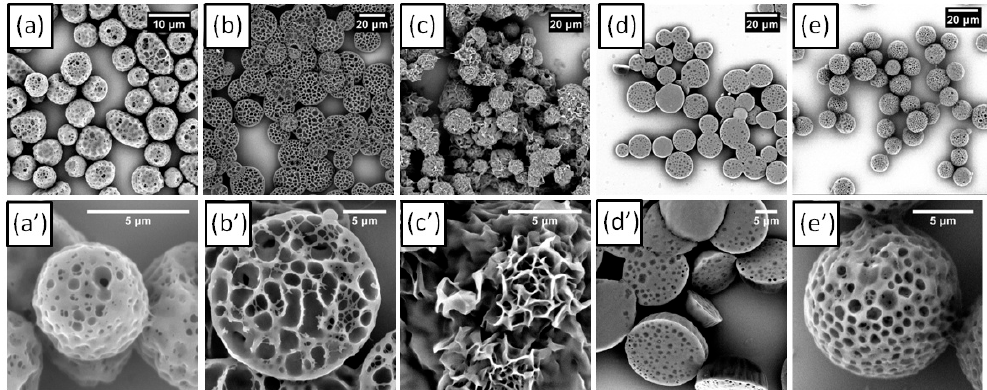
Figure 2. SEM images of poly( ε -caprolactone) (PCL)-dichloromethane (DCM) microparticles (MPs) collected in the organic solvent (non-solvents): ( a ) methanol; ( b ) ethanol; ( c ) 1,2-propanediol; ( d ) n -butanol; ( e ) tetraethyl orthosilicate. ( a’ – e’ ) High-magnification images showing the surface detail of the same porous MPs from ( a – e ), respectively.